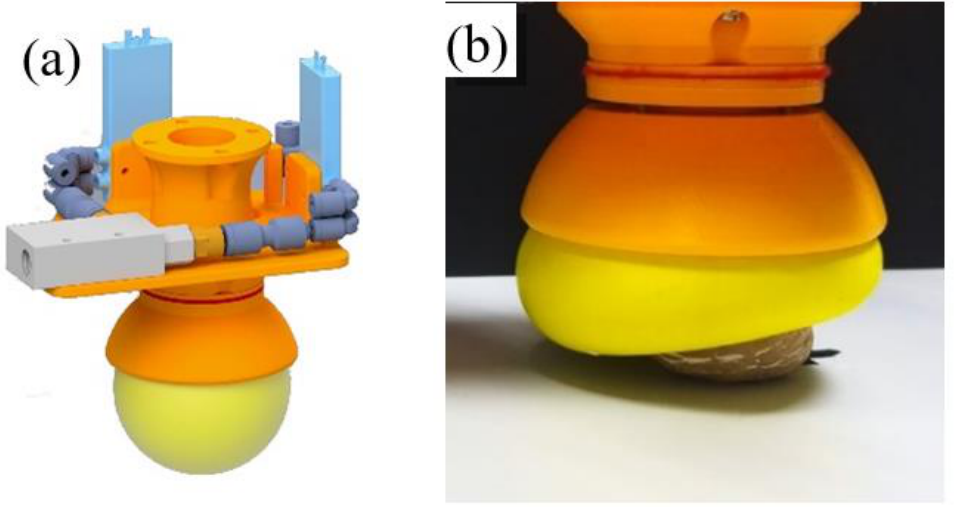
Figure 4. Second gripper: ( a ) CAD model of the gripper, ( b ) Gripper during the operation.